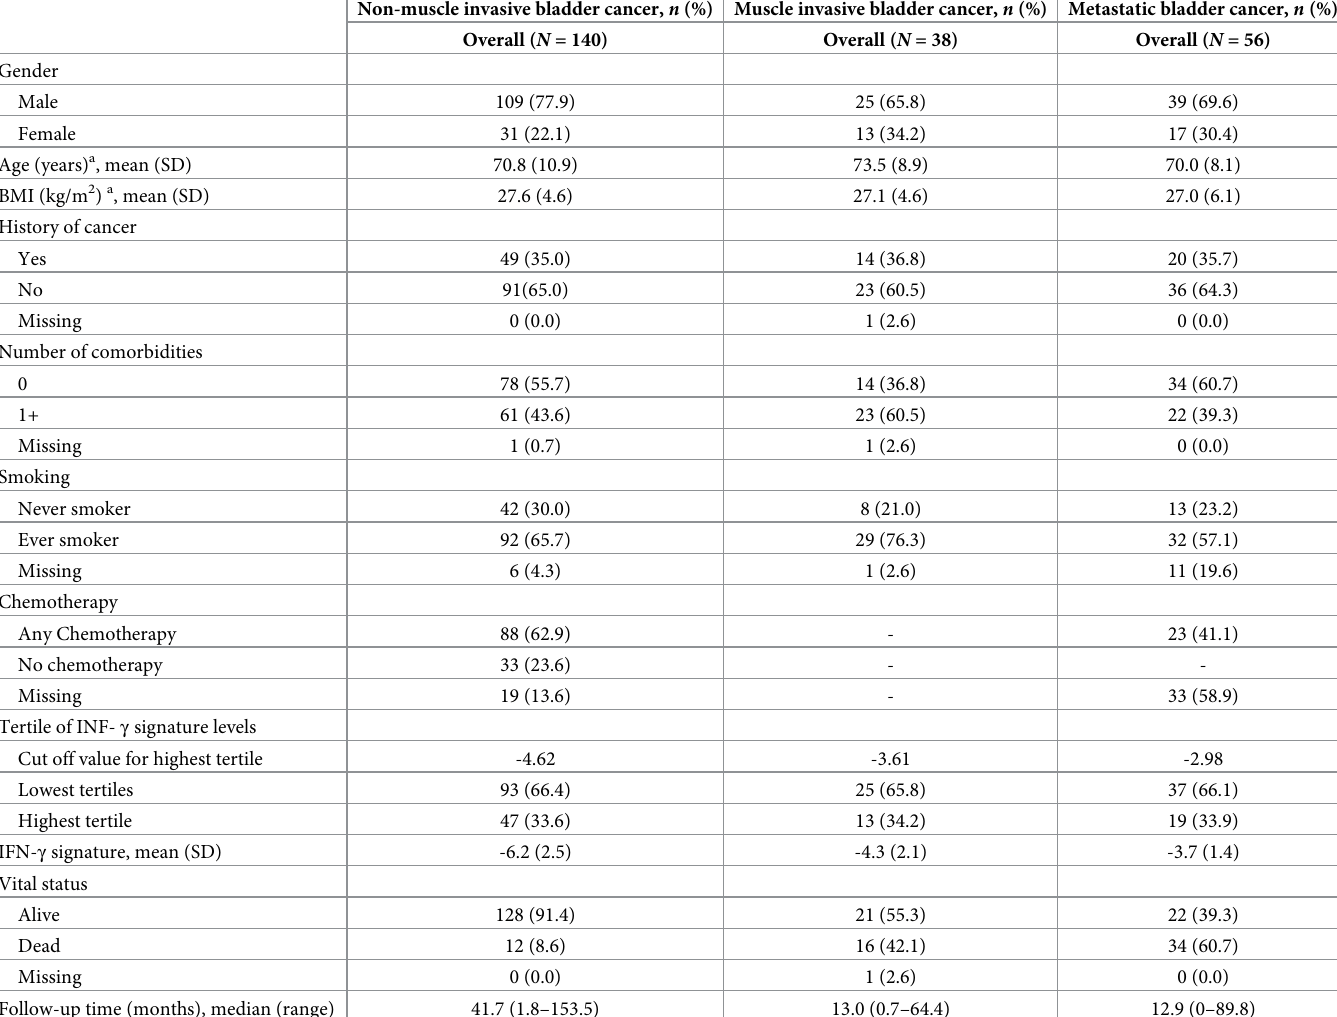
Table 1. Characteristics of bladder cancer patients by stage. Mt Sinai Hospital system and North Shore Long Island Jewish Health System, New York, New York. 2004–